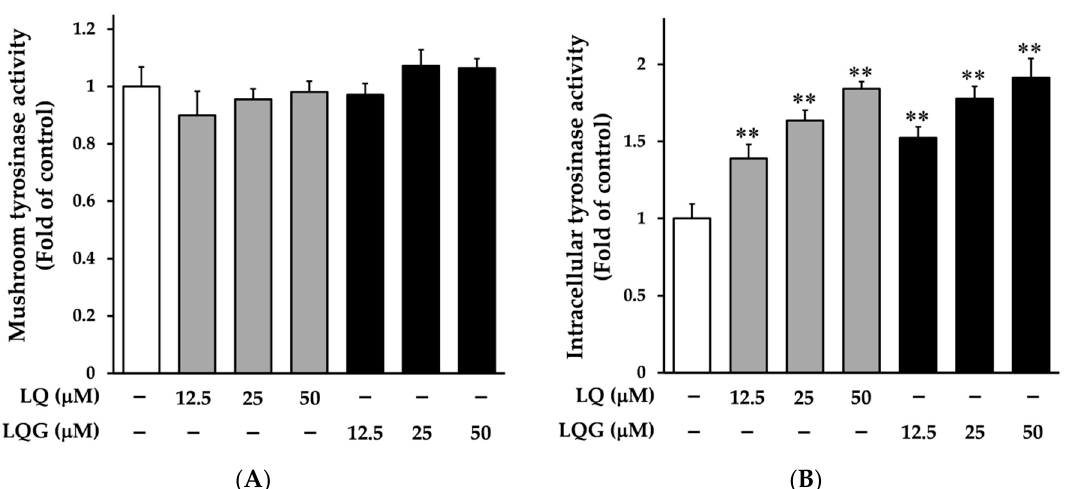
Figure 3. Effects of LQ and LQG on tyrosinase activity. ( A ) The effects of LQ and LQG on mushroom tyrosinase activity were determined as described in Materials and Methods. There were no significant differences between the control and experimental groups ( p > 0.05). ( B ) B16-F1 cells were treated with LQ or LQG at the indicated concentrations for 72 h, and the intracellular tyrosinase activity was determined as described in Materials and Methods. Values are the mean ± SEM of three independent experiments. ∗∗ p < 0.01 versus control.